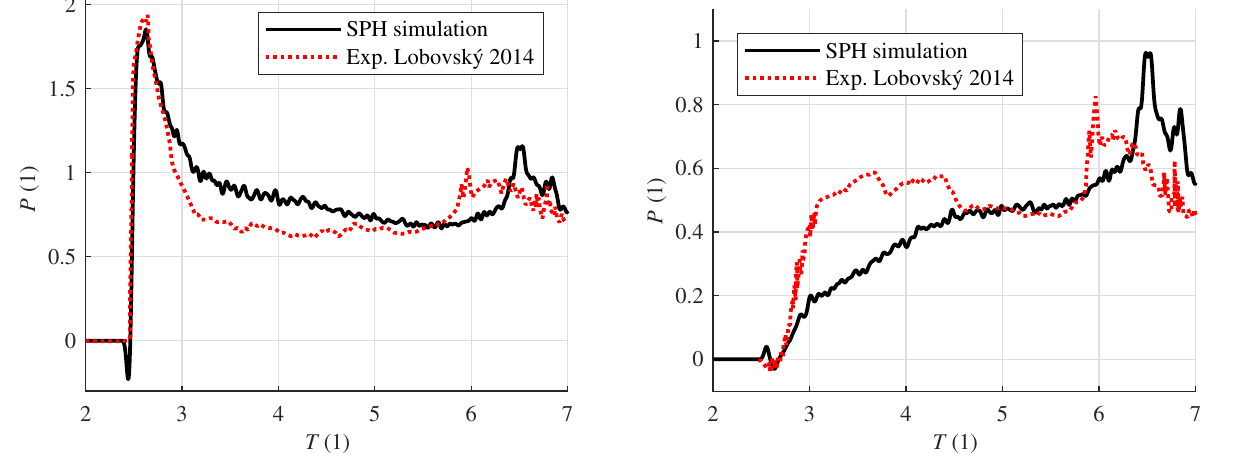
Fig. 11. Non-dimensional pressure as a function of non- dimensional time at sensor P2. Exp. Lobovský 2014 [2].